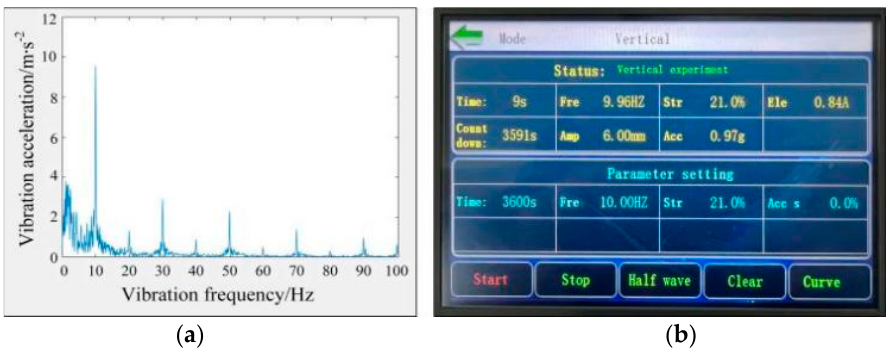
Figure 7. Vibration frequency analysis and parameter setting. ( a ) Vibration frequency domain dia-